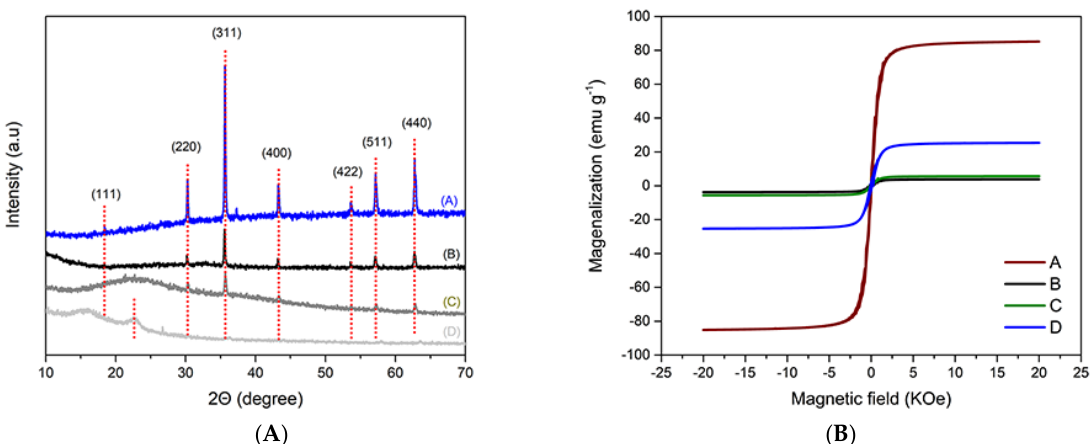
Figure 6. ( A ) XRD patterns and ( B ) magnetization curves of (A) Fe 3 O 4 , (B) APAM-Fe 3 O 4 (C) TAPAM-Fe 3 O 4 and (D) TAPAM-PDA-Fe 3 O 4 .